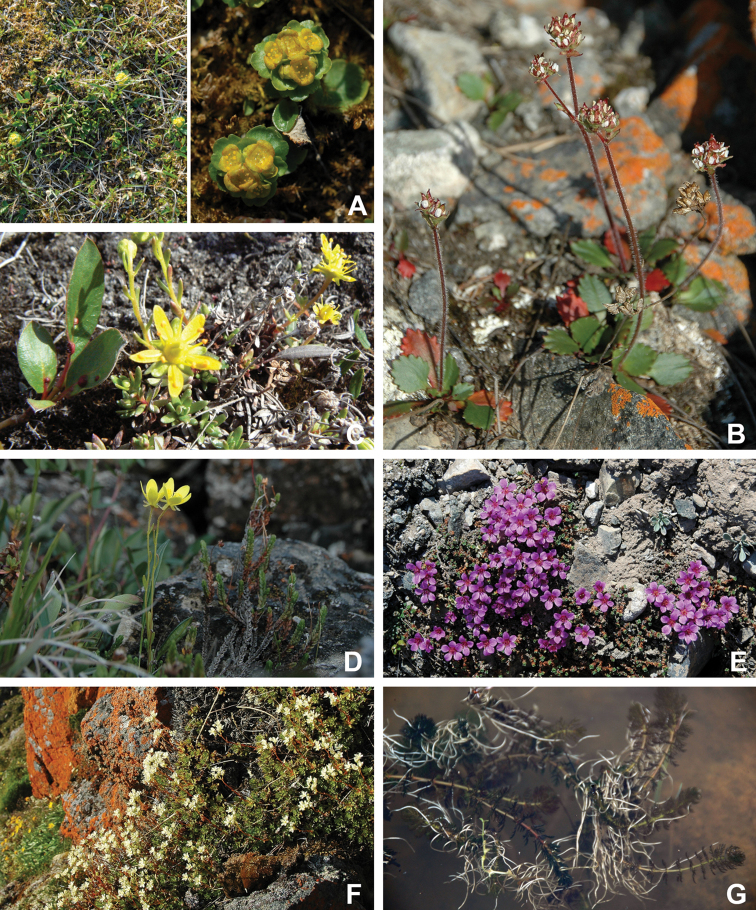
AChrysosplenium
rosendahlii habitat (left) and habit (right), Gillespie et al. 9753BMicranthes
nivalis habit, Gillespie et al. 9995CSaxifraga
aizoides habit, Boot Inlet, NT, 12 July 2010 DSaxifraga
hirculus habit, Kuujjua River, NT, 18 July 2010 ESaxifraga
oppositifolia habit, Gillespie et al. 9682FSaxifraga
tricuspidata habit, Kuujjua River, NT, 18 July 2010 GMyriophyllum
sibiricum habit, Johansen Bay, NU, 18 July 2008. Photos A by L.J. Gillespie B, D–G by R.D. Bull and C by P.C. Sokoloff.